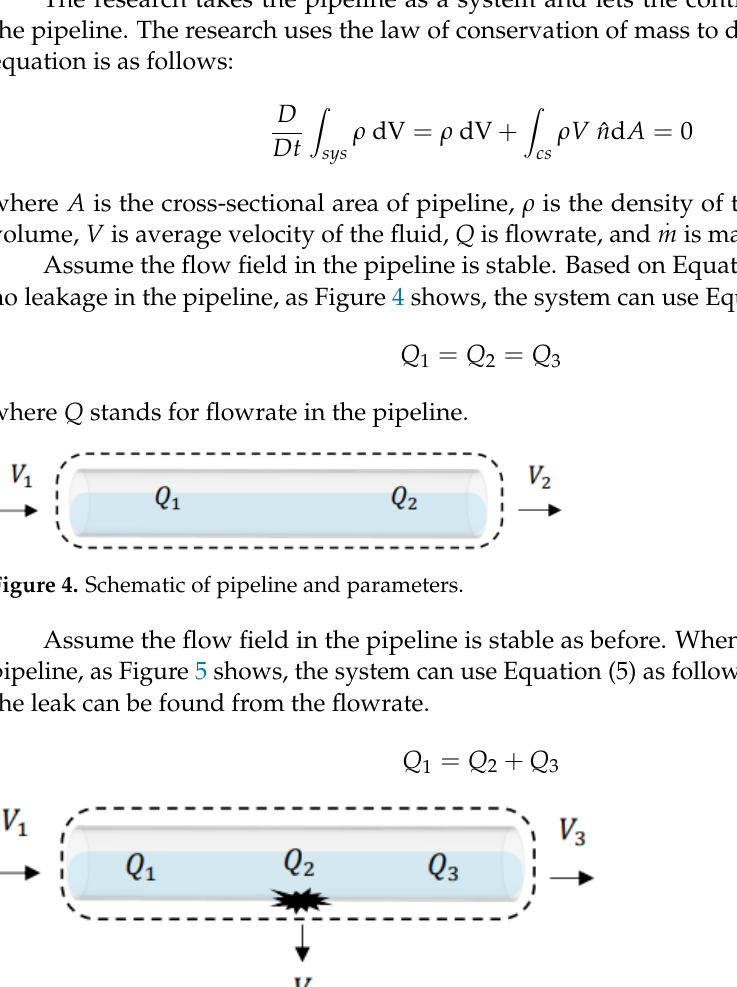
Figure 5. Schematic of broken pipeline and parameters.